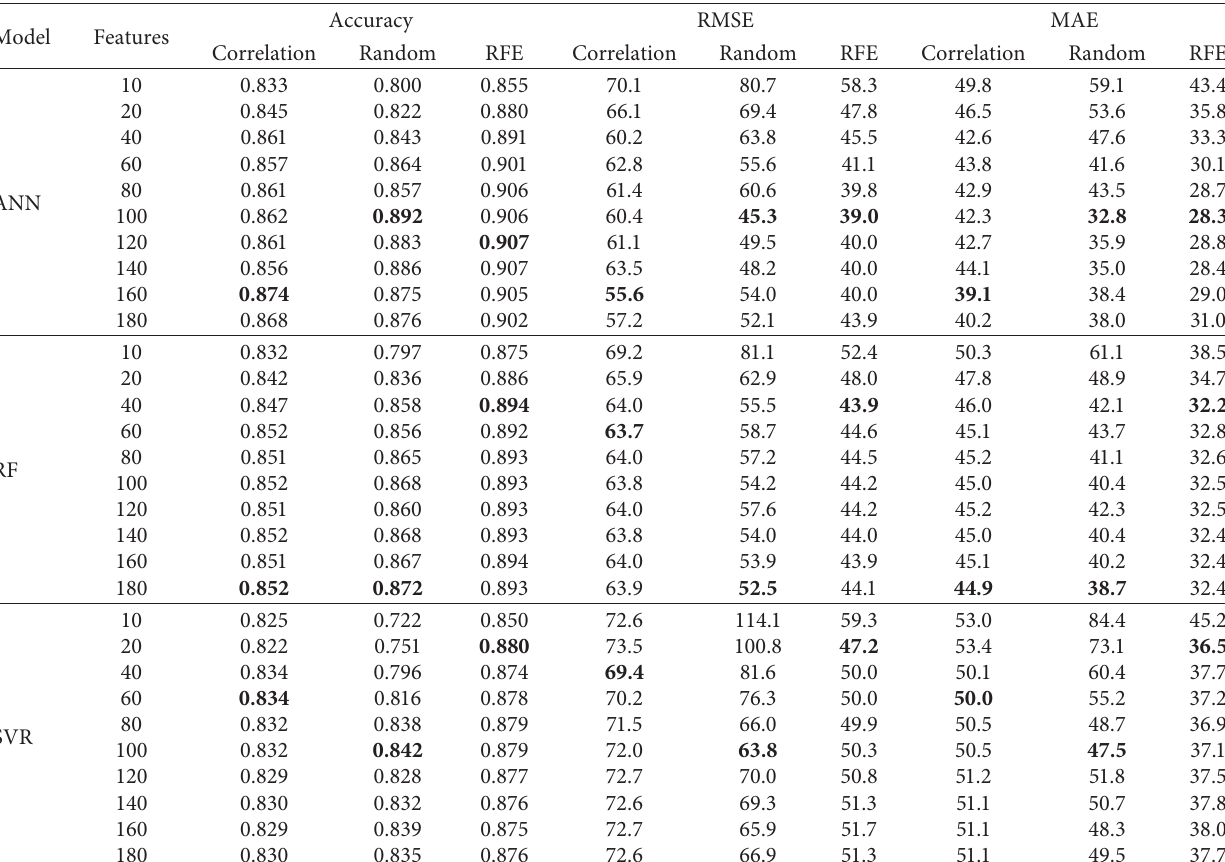
Table 8: Comparison of feature selection methods.